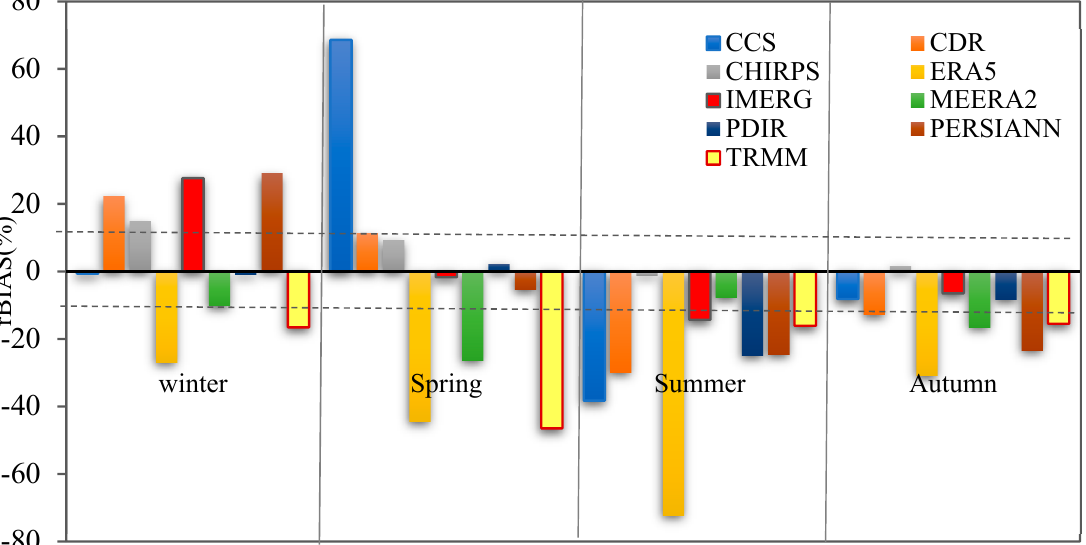
Figure 14. Spatial distribution of RMSE (mm/day) estimated for nine precipitation products in Pakistan.